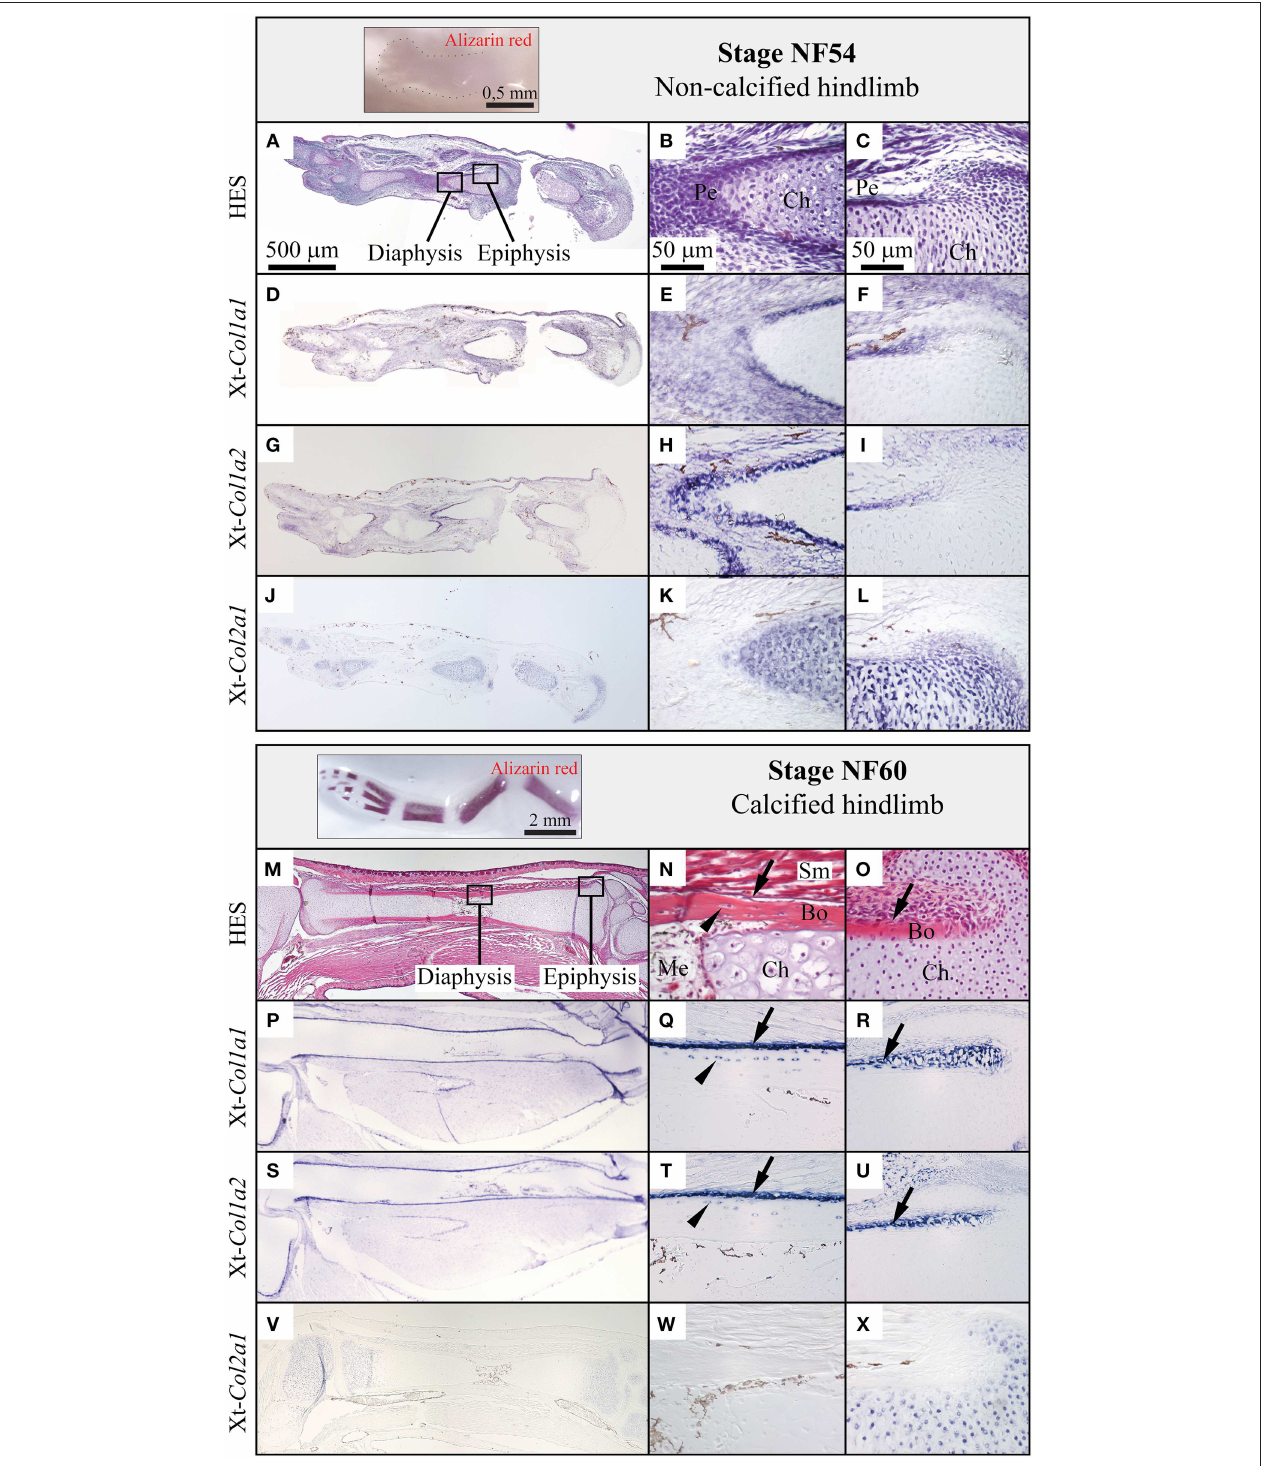
FIGURE 3 | Comparison of the Col1a1 , Col1a2 , and Col2a1 expression patterns during Xenopus tropicalis hindlimb development. Stage NF54 (top panel) or NF60 (bottom panel) hindlimbs were examined by whole mount Alizarin red staining (insets), sectioned along the proximo-distal axis and stained with HES, (A–C, M–O) or processed by in situ hybridization for the Xt- Col1a1 , Xt- Col1a2, and Xt- Col2a1 probes, (D–L, P–X) . Results are shown for the whole skeletal element (left column, scale bar: 500 µ m) and higher magnifications of the diaphysis (middle column, scale bar: 50 µ m) and epiphysis (right column, scale bar: 50 µ m). Arrows and arrowheads show osteoblasts and osteocytes, respectively. In situ hybridization signal is light to dark blue, and brown endogenous X.t. pigment cells are visible on most sections. Legend: Bo, bone; Ch, chondrocytes; Me, medulla; Pe, perichondrium; Sm, striated muscles.